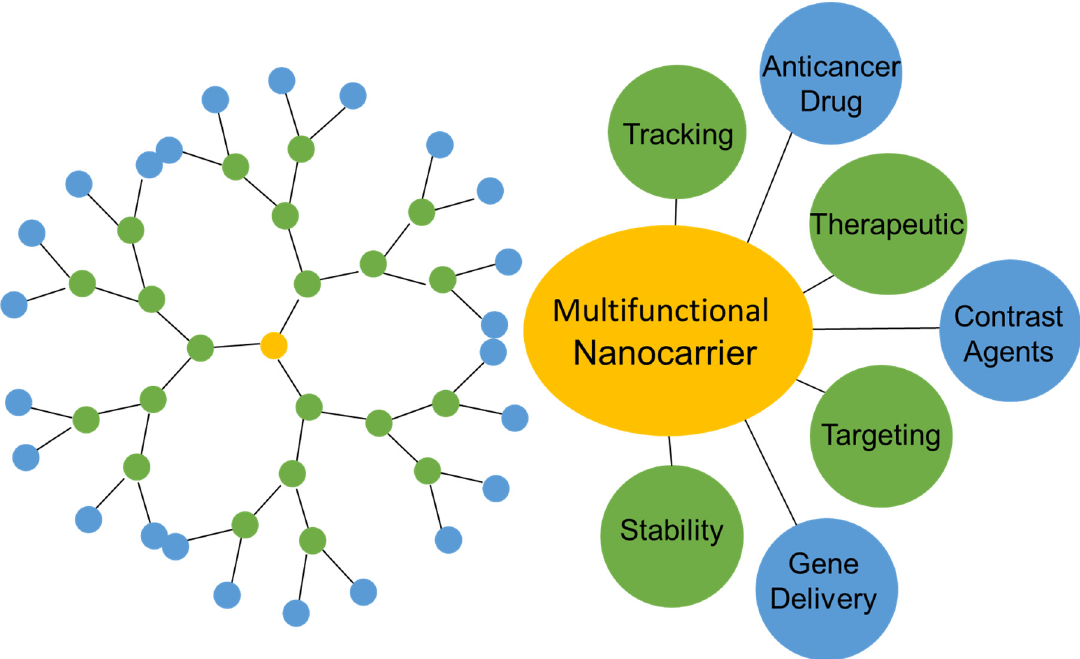
Figure 1. Dendrimers applications.